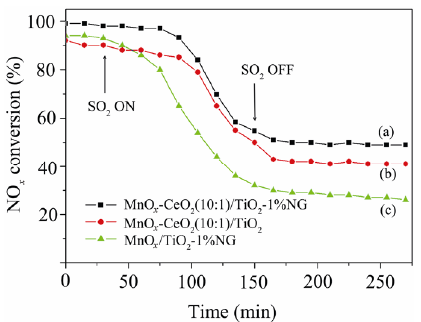
Fig. 7 NH 3 -SCR performance of the catalysts. Reaction conditions: 500 ppm NO, 500 ppm NH 3 , 6% O 2 , and balance N 2 , GHSV = 30000 h − 1 .